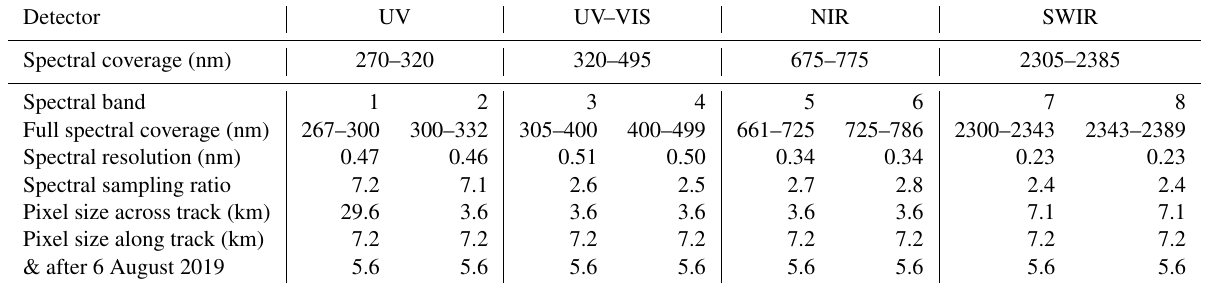
only contain the parameters a 0 , a 1 , a 2 , T , and s (cid:63) . This